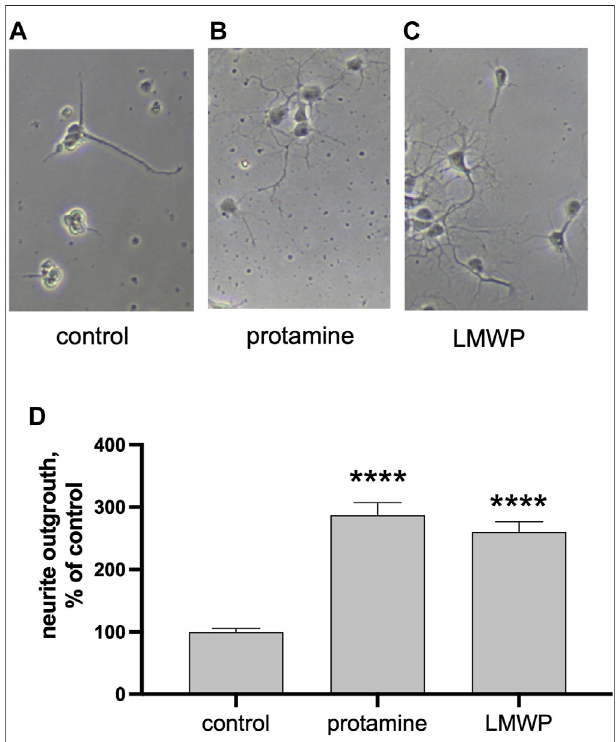
FIGURE 3 | Precoated protamine and LMWP induce neurite outgrowth as compared to control. (A – C) Morphology of hippocampal neurons cultured for 2 days on noncoated control plates or plates precoated with 10 μ g/ml of protamine or the 14 amino acid fragment LMWP. (D) Quanti fi cation of theeffectofprotamineandLMWPonneuriteoutgrowthmeasuredfromabout 70 neurons/ replicate and normalized to the control level. **** p < 0.0001; ANOVA followed by pairwise comparison with Fisher ’ s LSD test versus the control group; n = 7.